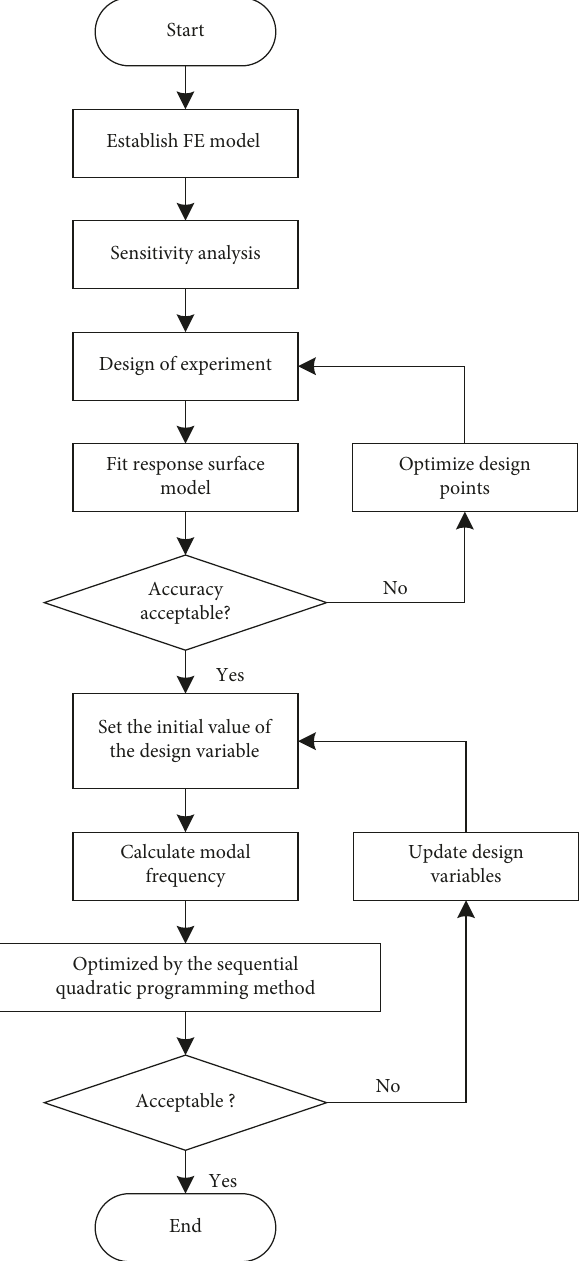
Figure 1: Flowchart of the optimization